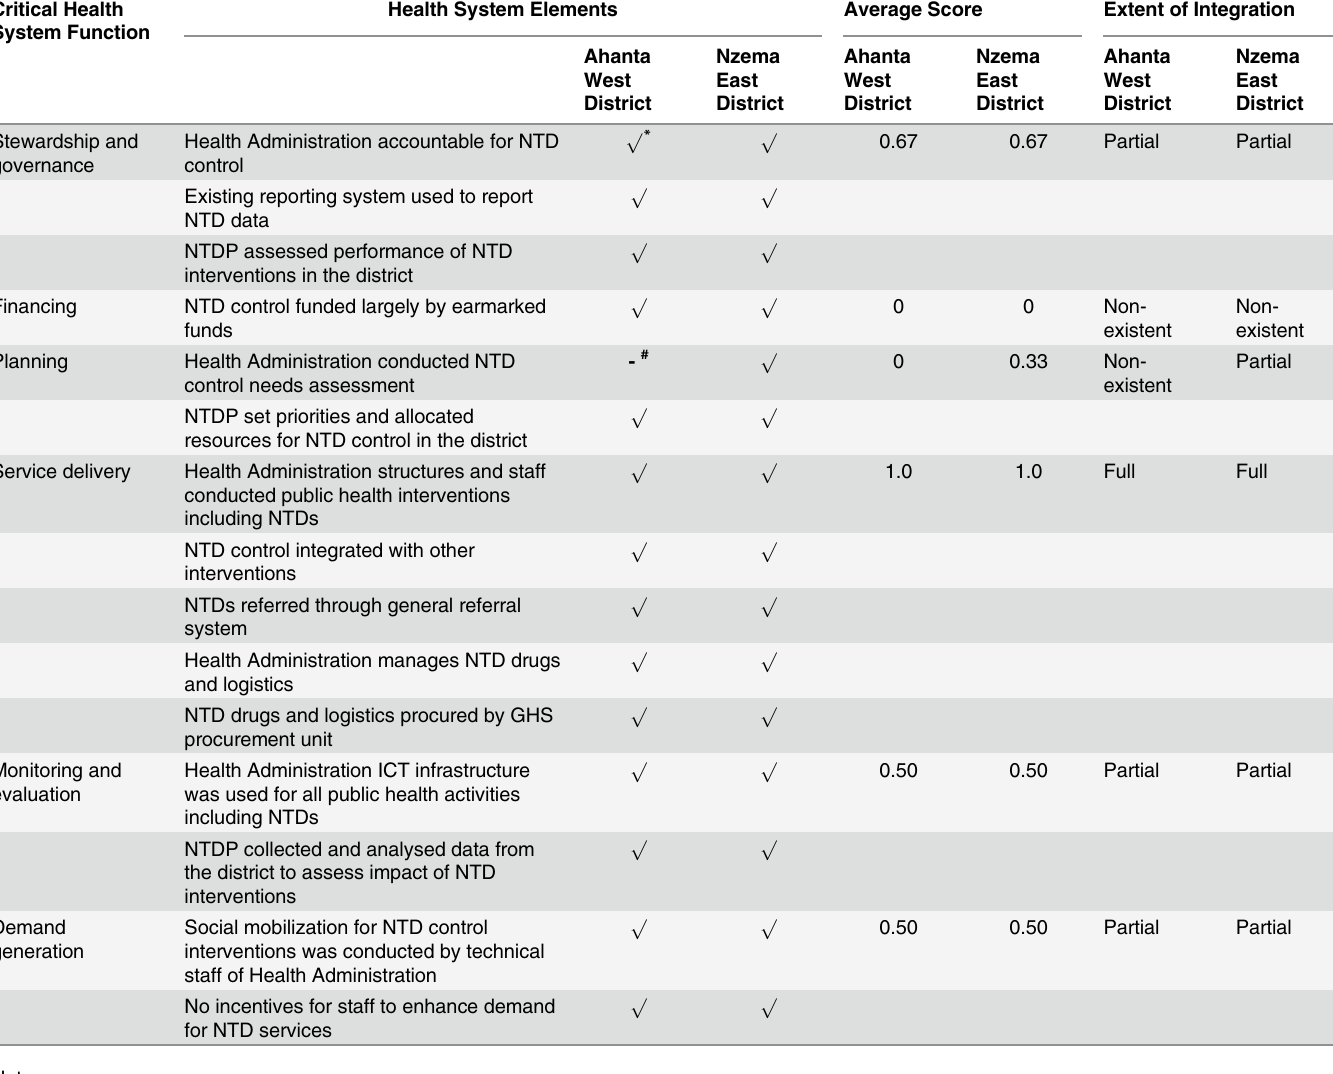
Table 4. Extent of integration of health system function at district level of health system. Critical Health System Function